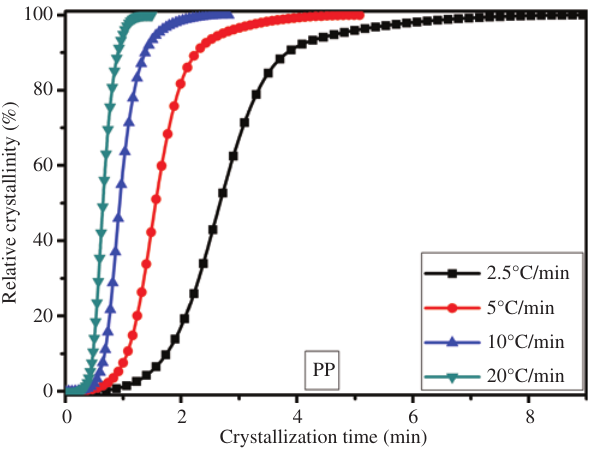
Figure 3 Plots of relative crystallinity percentage versus time for PP.